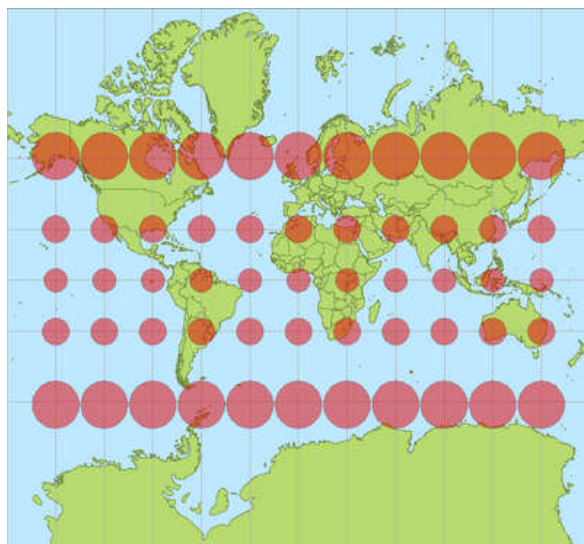
Figure 10 . Variation in metres per pixel with latitude on the Mercator projection. Sizes of circles are incorrect; they should be opposite (OpenStreetMap Wiki,